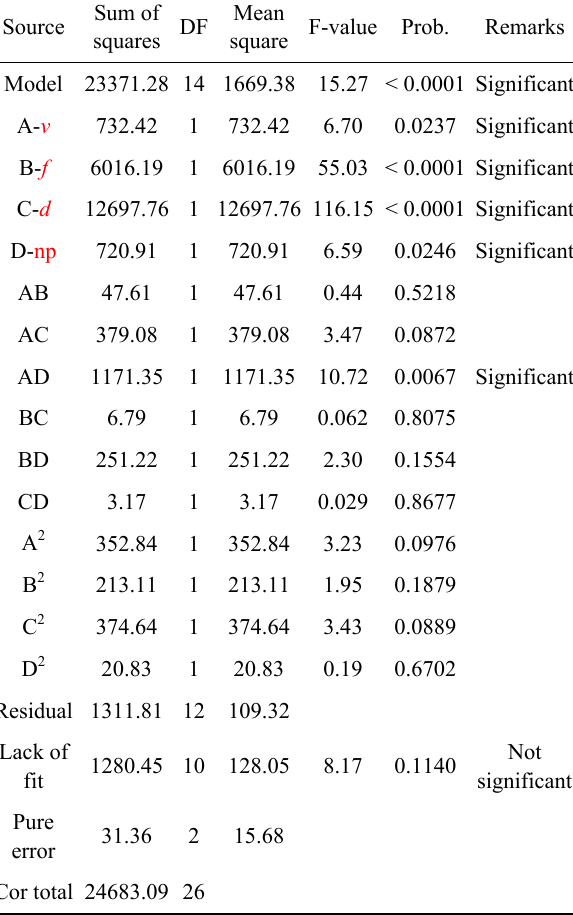
Table 6 ANOVA table of tool wear (VB) for Al-MWCNT hybrid